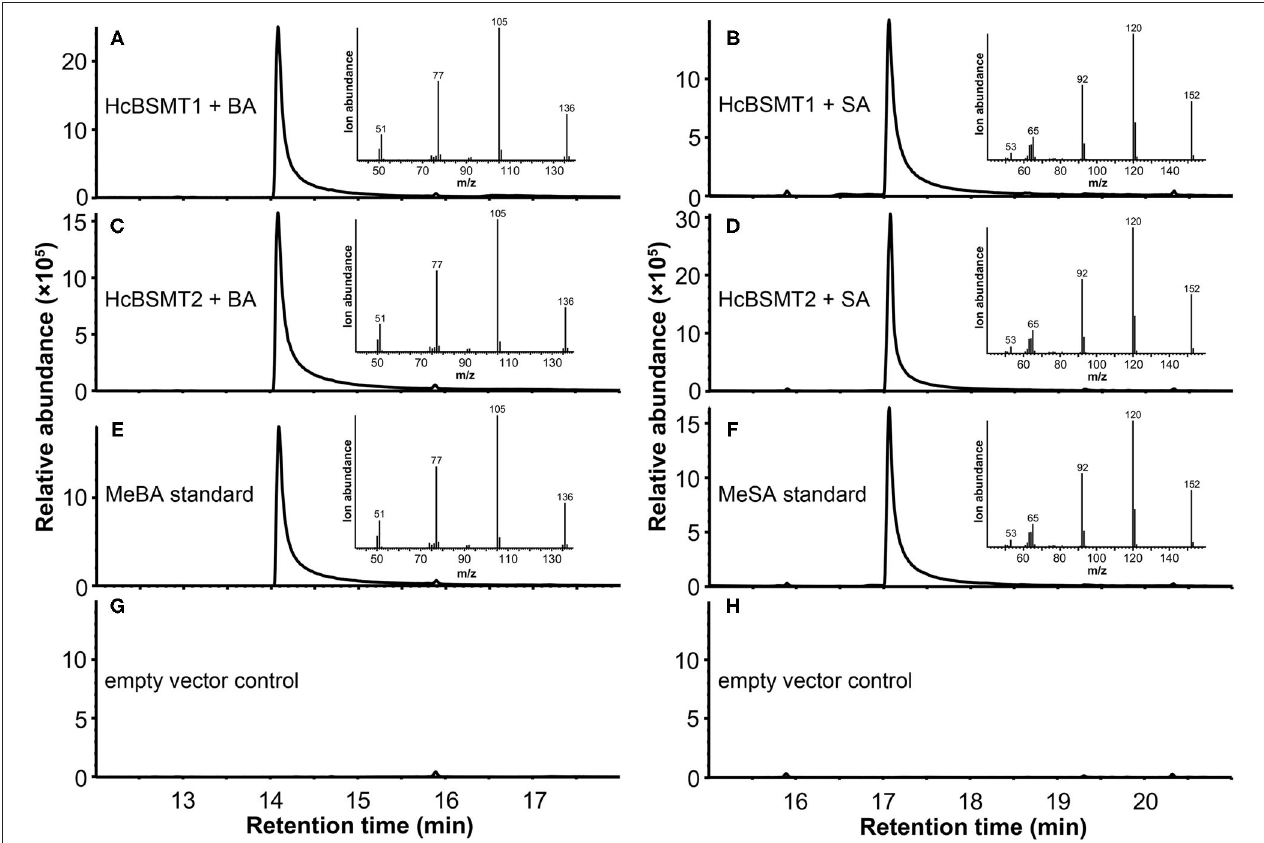
FIGURE 3 | GC-MS analysis of methylated products generated by recombinant HcBSMTs from benzoic acid (BA) and salicylic acid (SA). (A–D) Total ion chromatogram of reaction products formed by HcBSMT1 (A,B) and HcBSMT2 (C,D) after incubating with the substrates SAM and BA (A,C) or SA (B,D) , respectively. (E,F) Total ion chromatogram of methyl benzoate (MeBA) and methyl salicylate (MeSA) authentic standards. Insets in panels (A–F) represent mass spectra of corresponding products. (G,H) Chromatogram of the products generated by incubating crude protein extracts of empty vector control with the substrates SAM and BA (G) or SA (H) ,